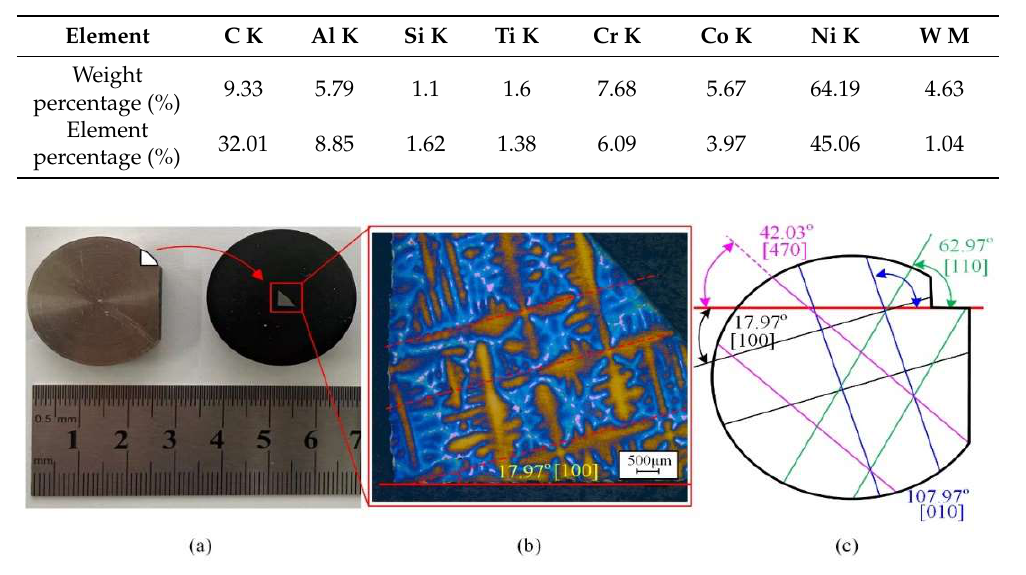
Table 1. The element distribution of DD407.